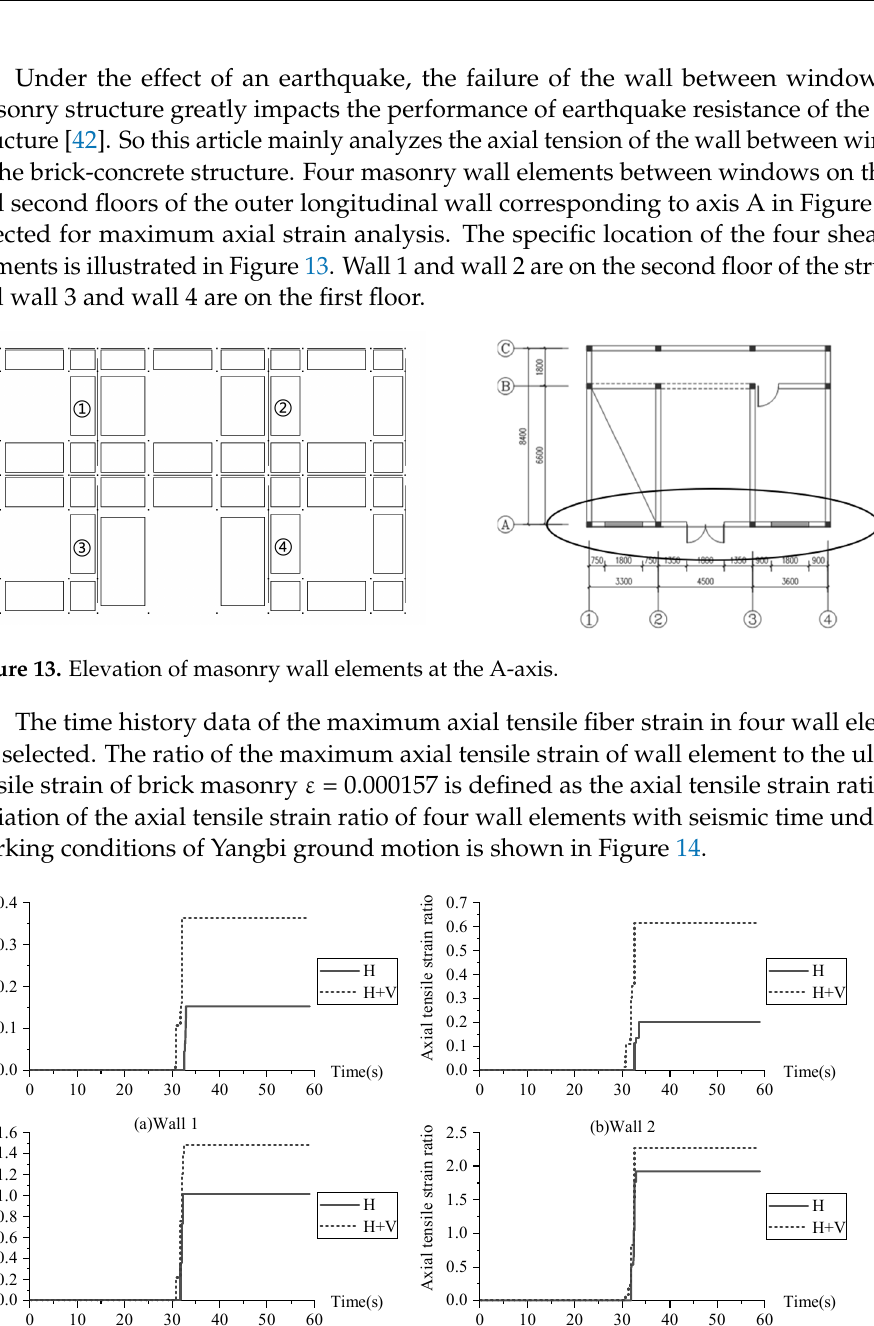
Figure 12. Brick masonry tensile stress − strain curve and Perform − 3D skeleton curve.